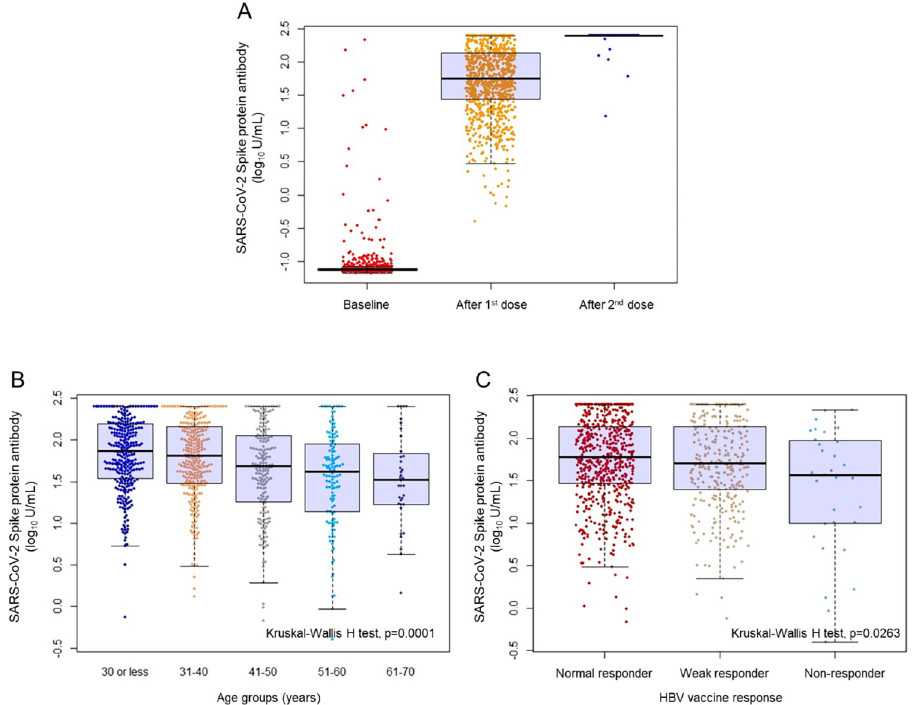
Fig 1. Spike protein antibody levels of patients in the study. (A) Distribution of SARS-CoV-2 spike protein antibody titers (logarithmic scale) at baseline, after one dose of BNT162b2 mRNA-1273 COVID-19 vaccine, and after two doses (n = 954). (B) Distribution of SARS-CoV-2 spike protein antibody titers (logarithmic scale) after a single dose of BNT162b2 mRNA-1273 COVID-19 vaccine, stratified by age groups (n = 954). (C) Distribution of SARS-CoV-2 spike protein antibody titers (logarithmic scale) after a single dose of BNT162b2 mRNA-1273 COVID-19 vaccine, stratified by history of HBV vaccine response (n = 954).